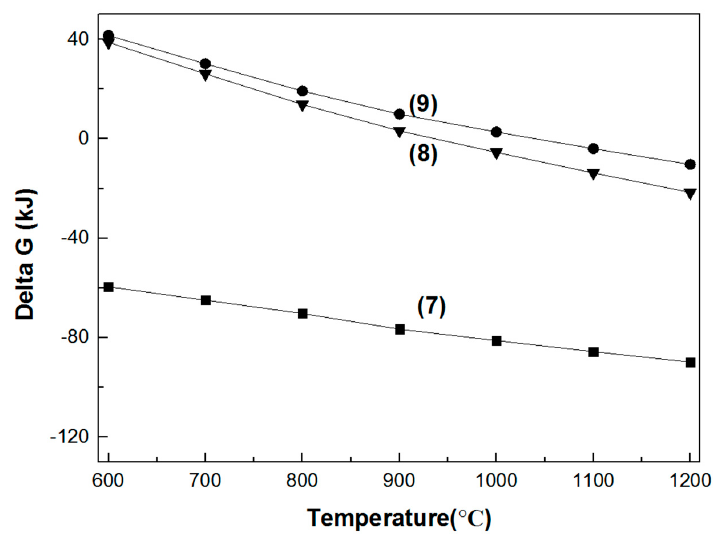
Figure 6. Gibbs free energy of the reaction between Na 2 CO 3 and the three spinels in the 600 – 1200 °C temperature range. (7) Na 2 CO 3 + 1/2MgO · Cr 2 O 3 + 3/4O 2 = 1/2MgO + Na 2 CrO 4 + CO 2 ; (8) Na 2 CO 3 + MgO · Fe 2 O 3 = Na 2 O · Fe 2 O 3 + CO 2 + MgO; (9) Na 2 CO 3 + MgO · Al 2 O 3 = MgO + Na 2 O · Al 2 O 3 + CO 2